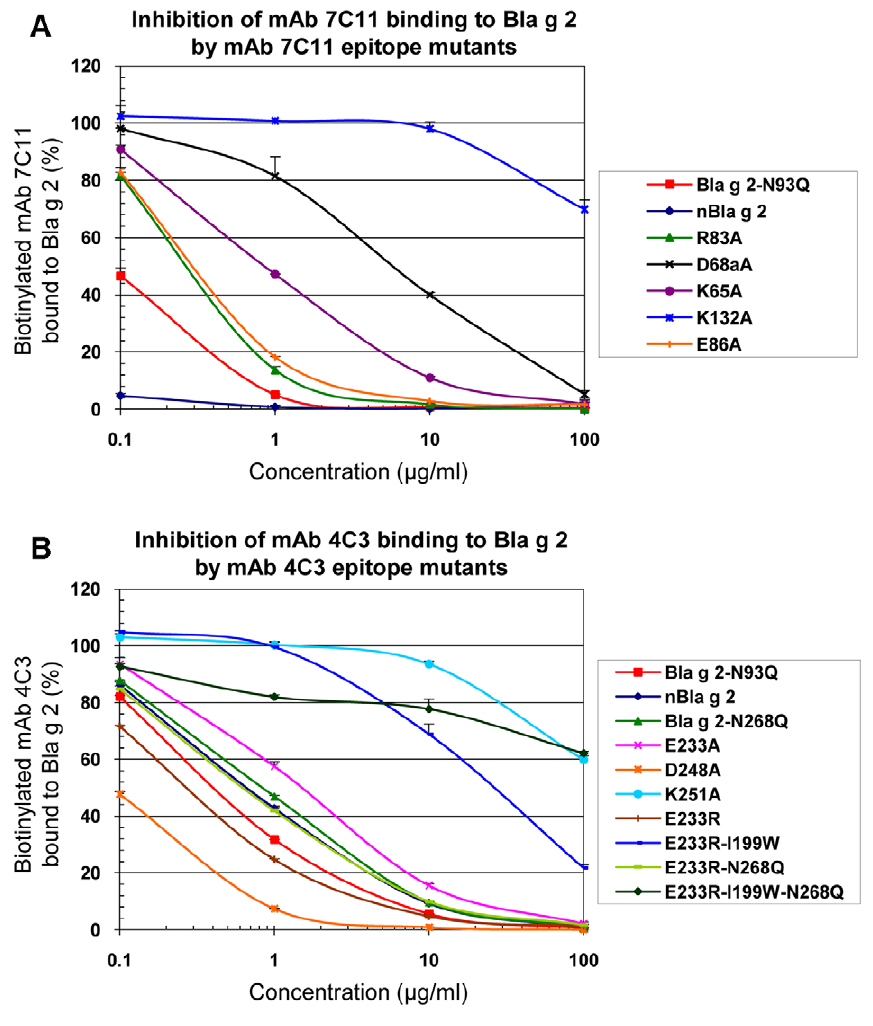
Figure 7. Inhibition of biotinylated mAb binding to rBla g 2 by allergen mutants using ELISA. A) Inhibition of binding of biotinylated- mAb 7C11 to rBla g 2-N93Q by mAb 7C11 epitope mutants. B) Inhibition of binding of biotinylated-mAb 4C3 to rBla g 2-N93Q by mAb 4C3 epitope mutants. Data are mean 6 standard deviation of duplicates from one representative experiment out of two performed for each panel.